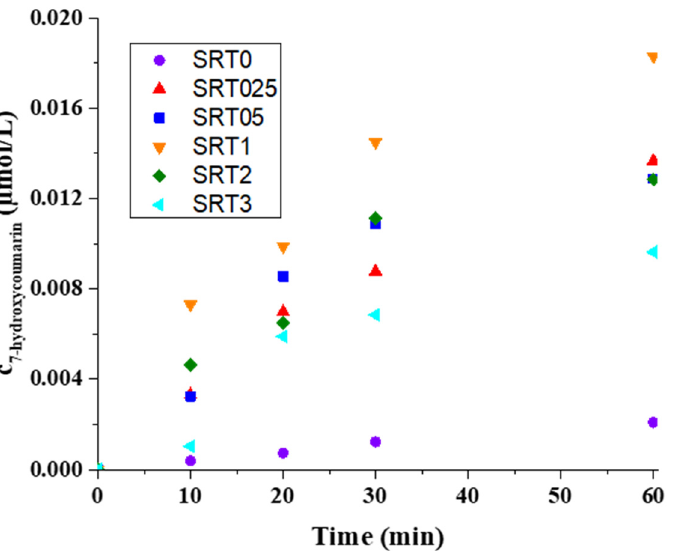
Figure 8. Production kinetics of 7-hydroxycoumarin from coumarin in the case of SrTiO 3 (SRT0) and in the case of the SRT samples.